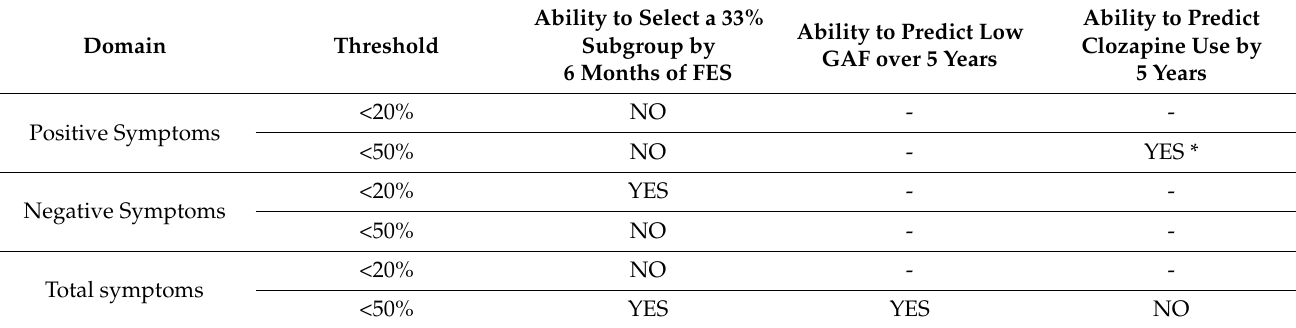
Table 3. Summary of